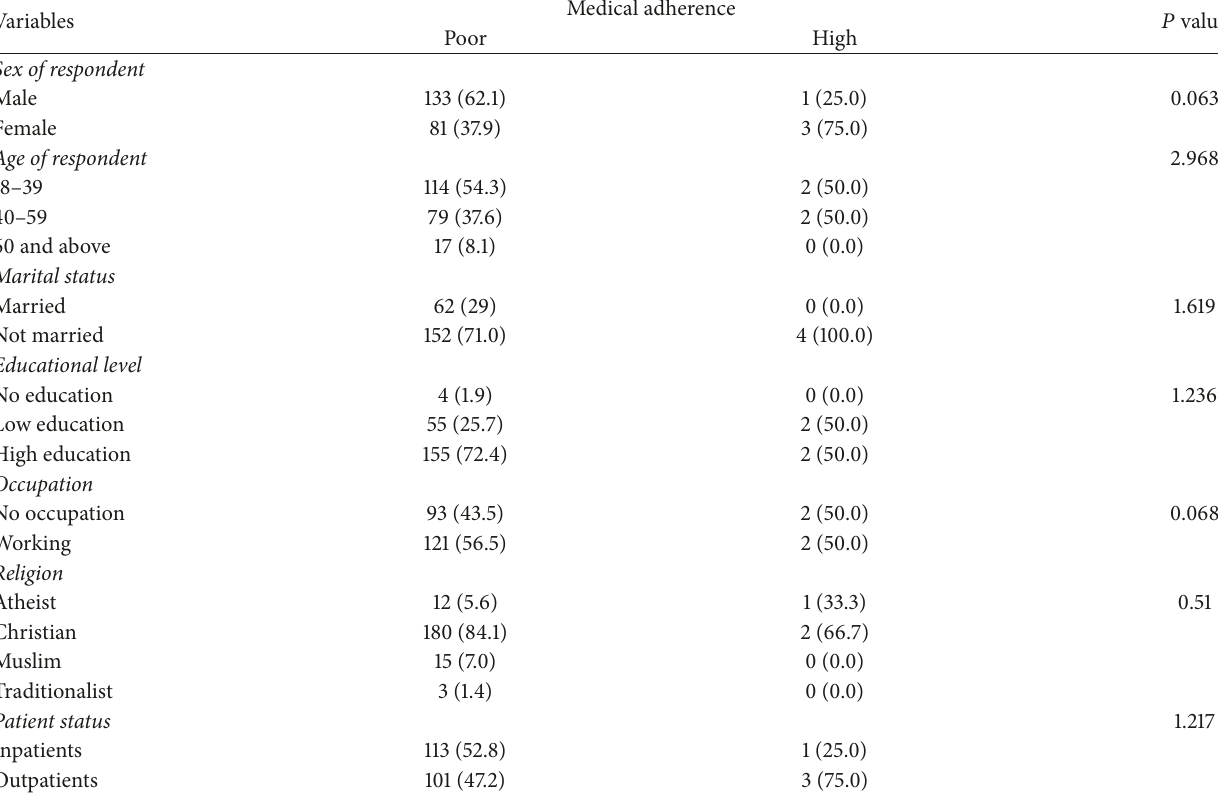
Table 9: Relationship between demographic characteristics and adherence to psychotropic medications.